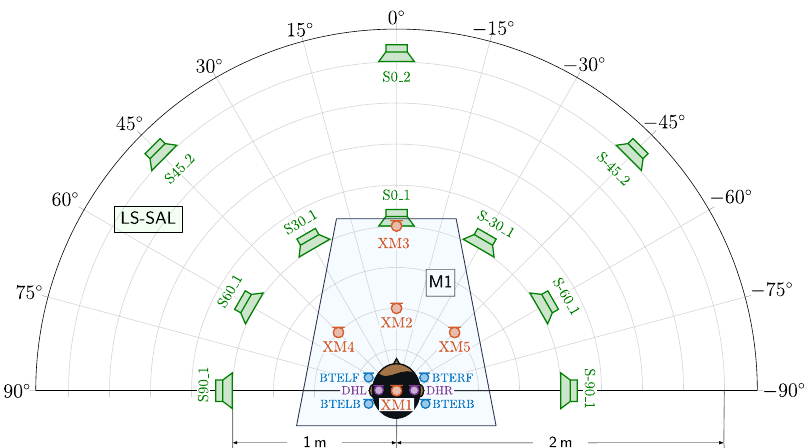
Fig. 3 Plan view of the M1 microphone configuration and the LS-SAL loudspeaker configuration. A description of the microphone and loudspeaker labels is given in Table 2. The radial grid spacing of the polar plot is 0.25 m. The DH is placed at a height of approximately 1.3 m ear level from the floor and all XMs are placed at a height approximately 1 m from the floor. The trapezoidal shape is used to represent the M1 microphone configuration in the floor plans of Fig. 6. For extracting the coordinates of the microphone and loudspeaker positions, the MATLAB or Python scripts discussed in Section 6.2 should be used